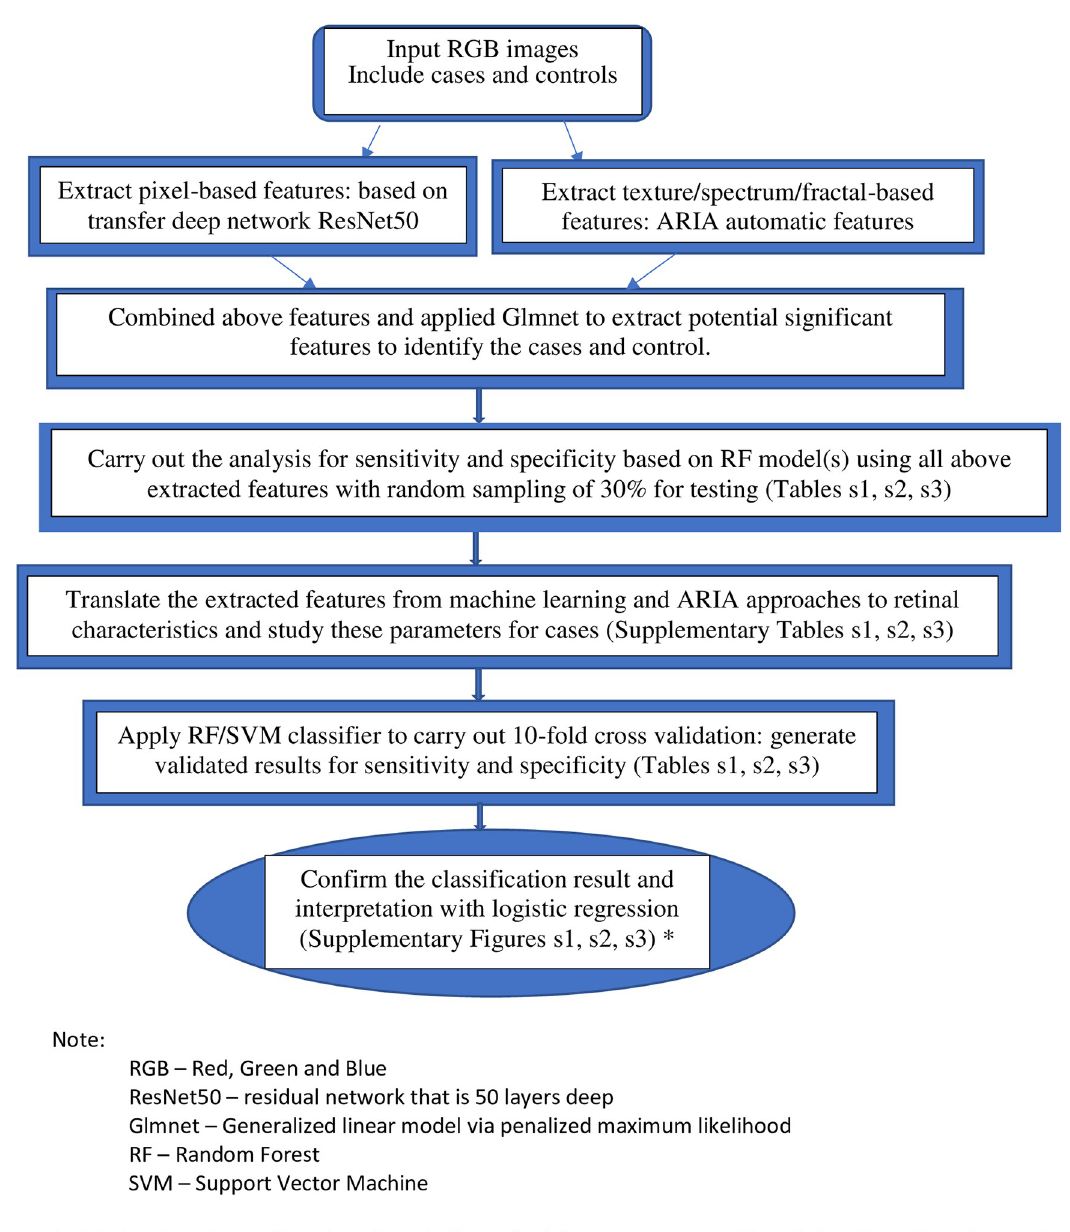
Fig 1. Flowchart of the method for the development of the classification models. ( Fig 2A ). The models showing the associations between traditional cardiovascular risk factors plus retinal characteristics for obstructive CAD are shown in Table 4 . For assessing the risk of obstructive CAD, the model including retinal variables combined with traditional risk factors had a sensitivity and specificity of 95.7% and 97.8%, respectively (AUC 0.991, 95% CI 0.978–